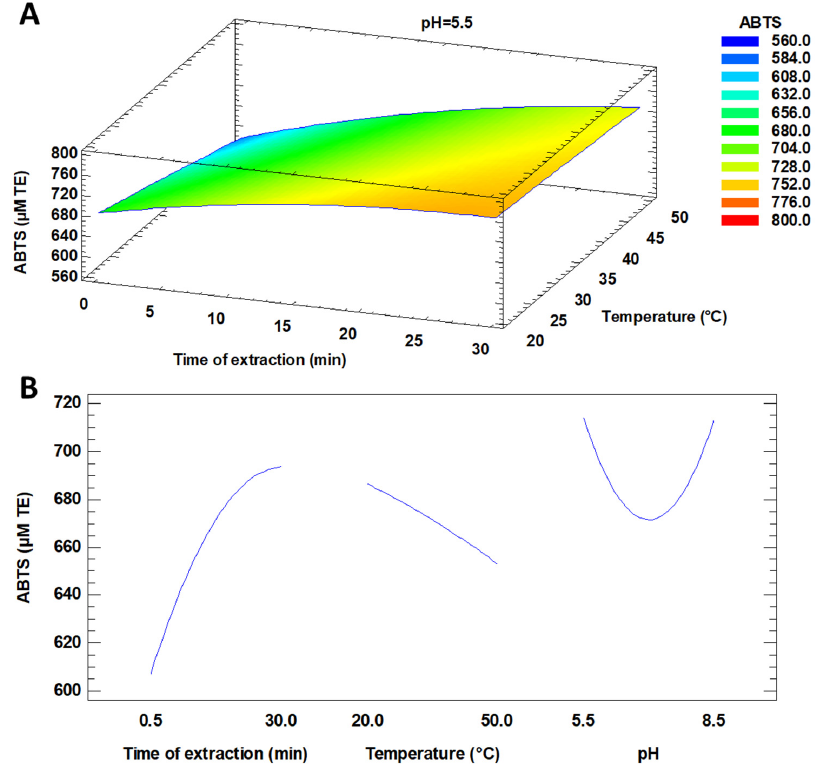
Figure 6. Influence of the different extraction conditions ( A ) and main effects chart for these condi- tions ( B ) on the total antioxidant activity ( µ M TE), measured by the ABTS method. The least relevant factor (highest p -value) has been set at its optimal